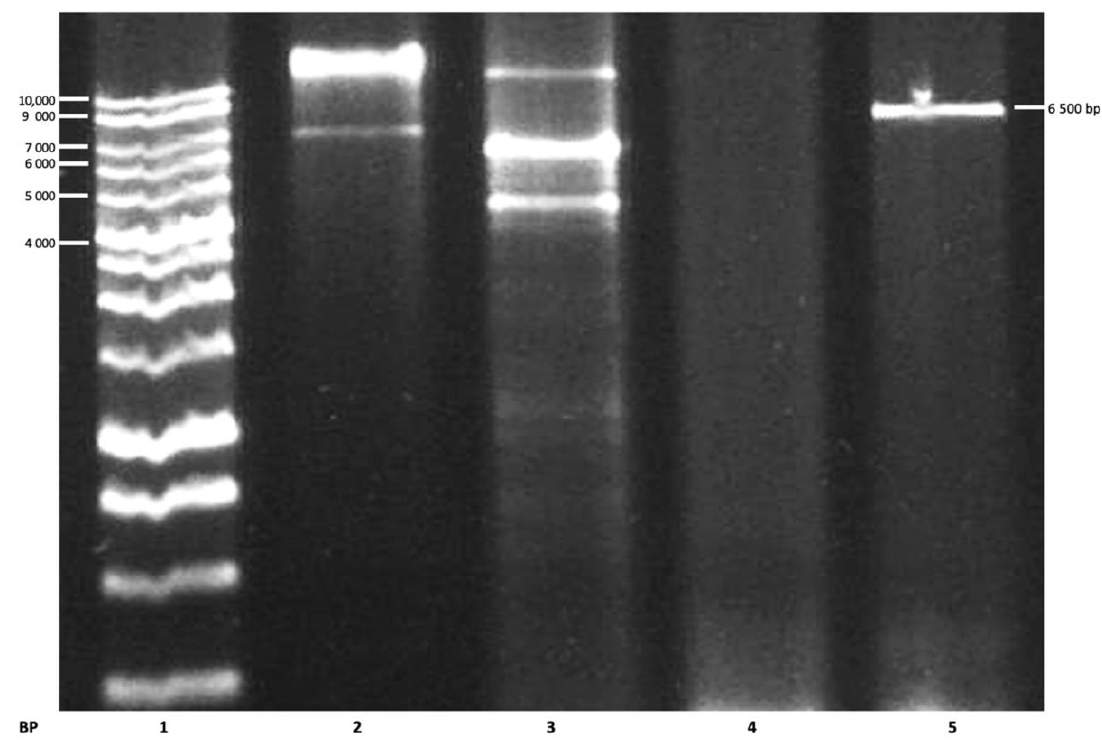
Figure 4. Electropherogram of the putative mutated plasmid. Lanes: 1, molecular weight ladder; 2, Wt plasmid; 3, positive control; 4, negative control; 5, putative mutated plasmid